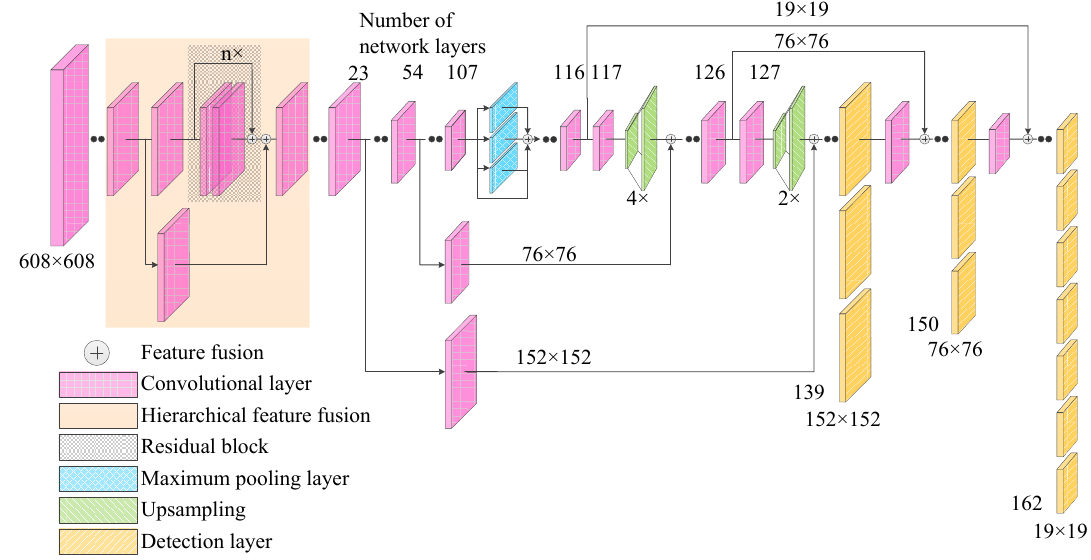
Figure 4. The network structure of the Improved YOLOv4